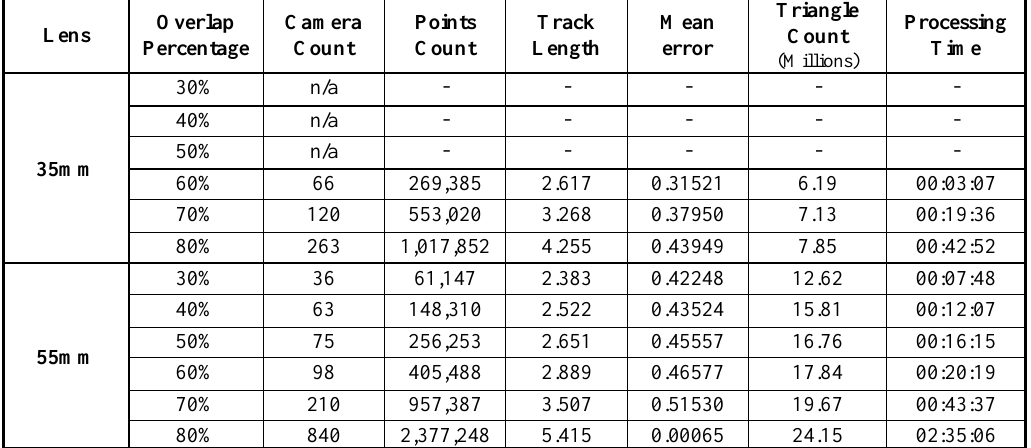
Table 1: Overlap percentage test